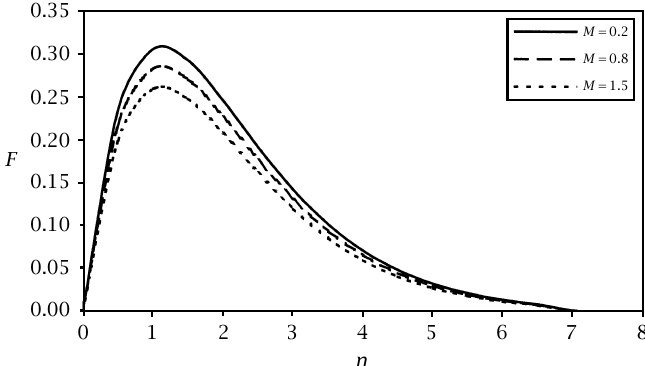
Figure 3.1 . The variation of F against η for m = 0 . 1 and R = 1.